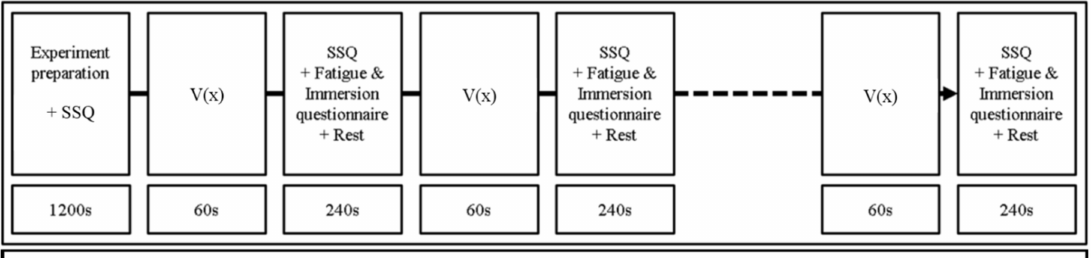
Figure 7. Experimental